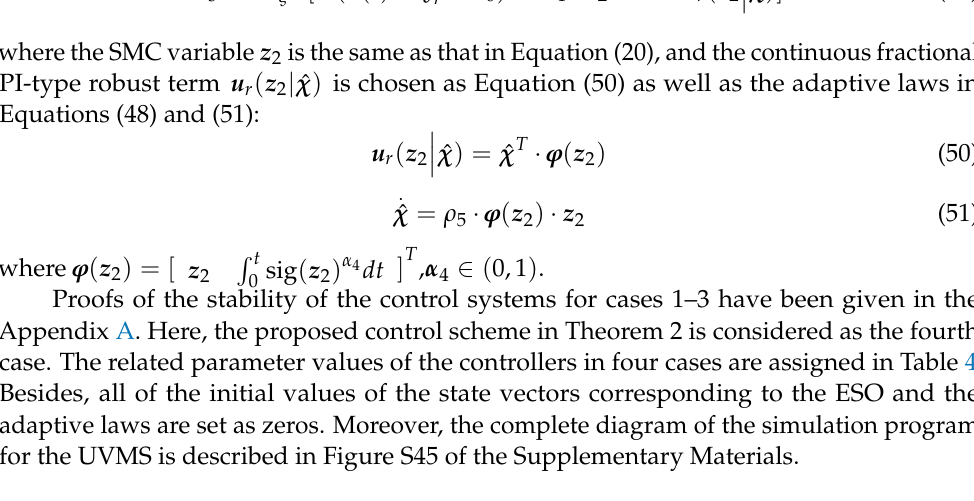
Table 4. The parameter values of the